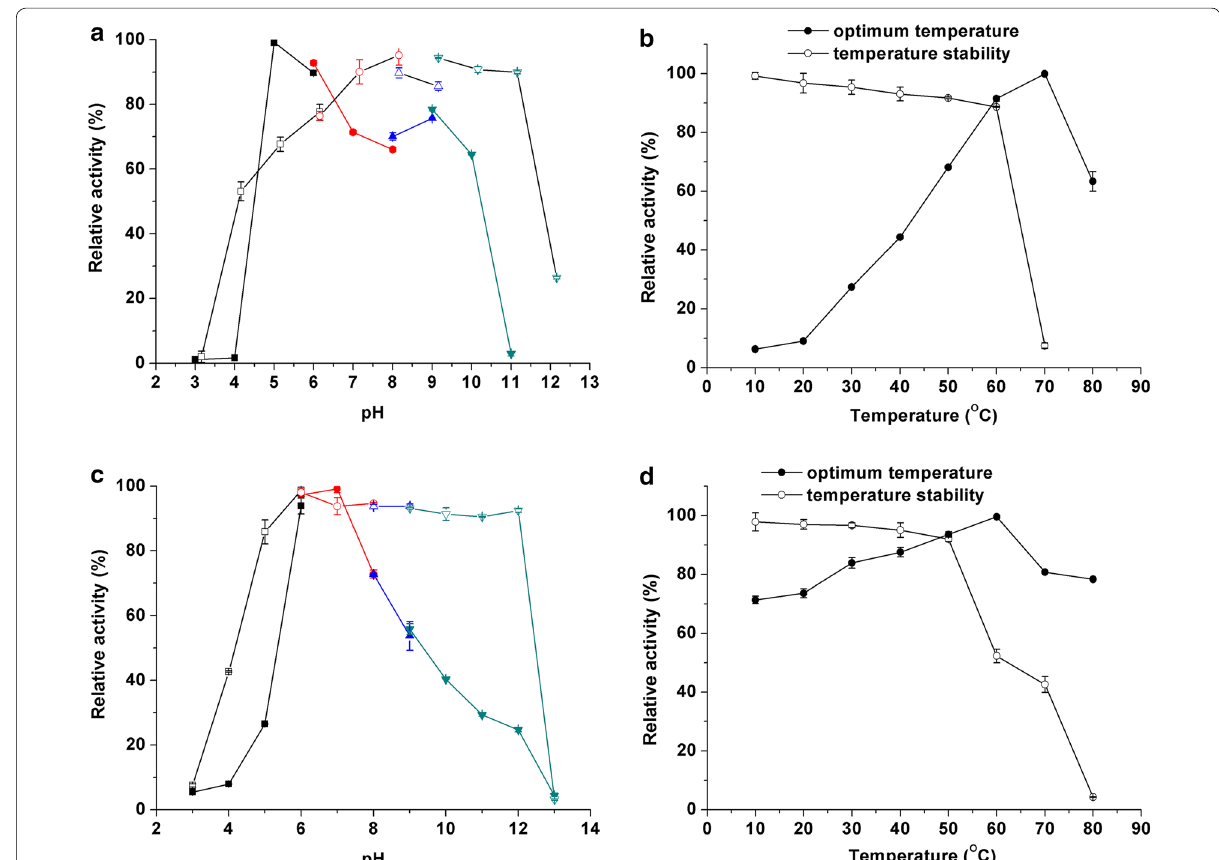
Fig. 3 Effects of pH and temperature on the activity of Cel5A and Cel9A. a pH profile and pH stability of Cel5A, solid symbols represent the optimum pH and hollow symbols represent pH stability; b temperature dependence and temperature stability of Cel5A; c pH profile and pH stability of Cel9A, solid symbols represent the optimum pH and hollow symbols represent pH stability; d temperature dependence and temperature stability of Cel9A